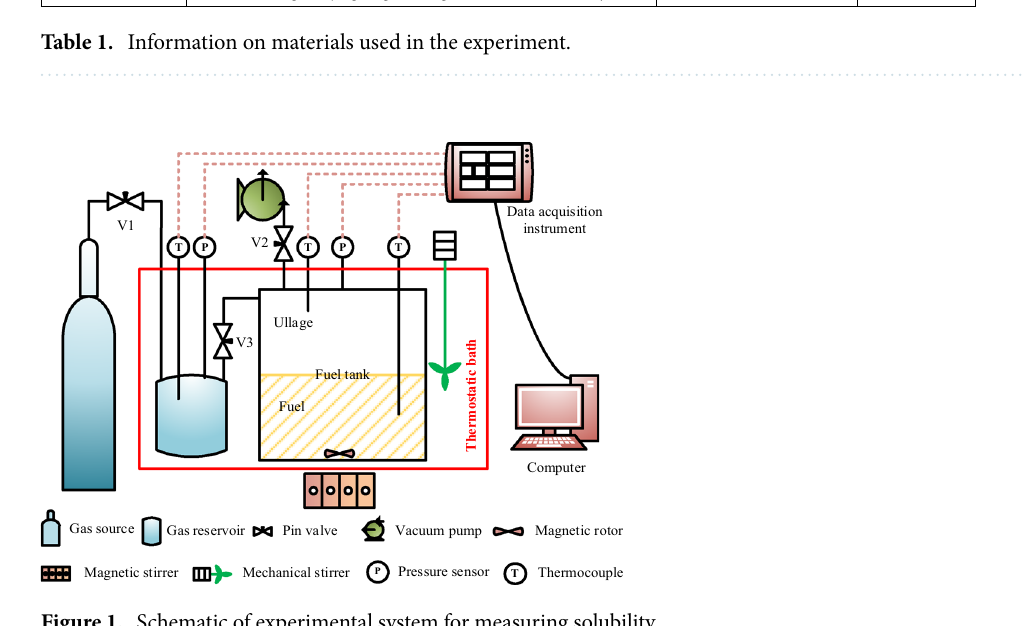
Figure 1. Schematic of experimental system for measuring